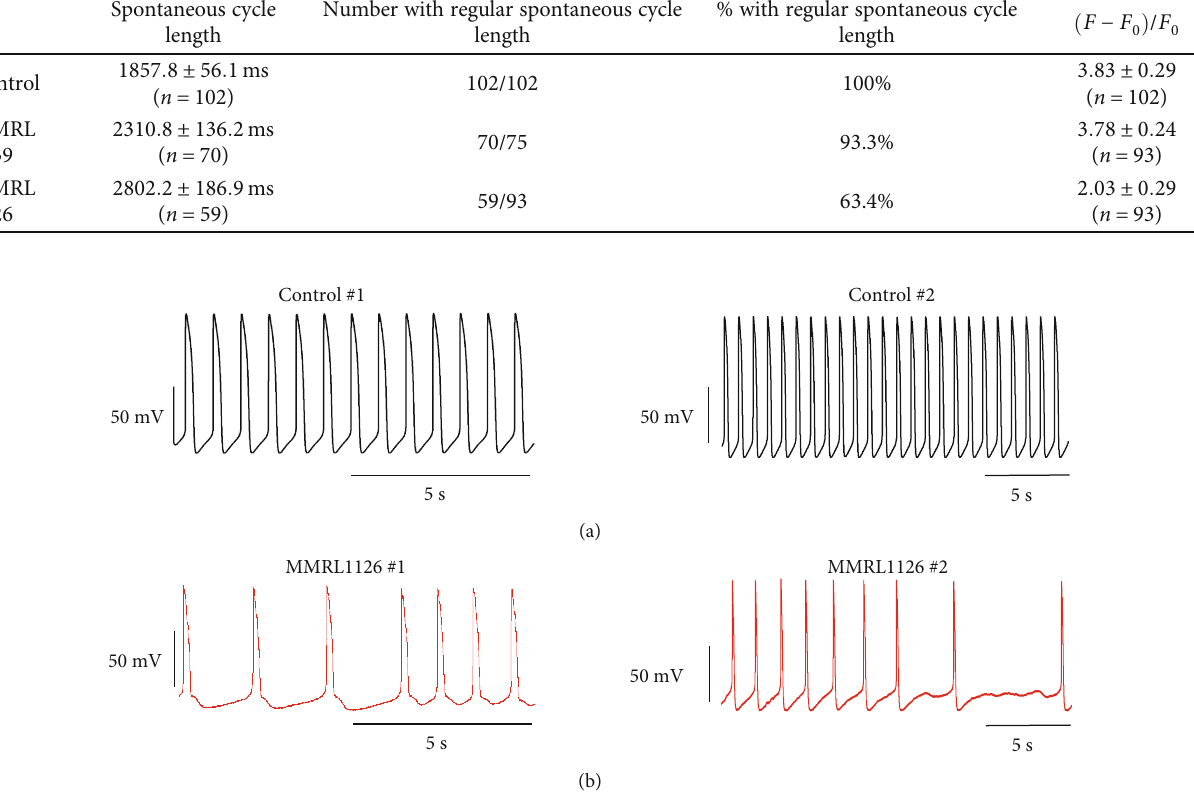
Figure 5: Action potential (AP) recordings obtained from WT and MMRL1126 monolayers. WT hiPSC-CMs were more hyperpolarized and had a larger V . In addition, hiPSC-CMs from MMRL1127 exhibited slower spontaneous activity, and some showed episodic activity. max Table 3: Electrophysiological parameters.